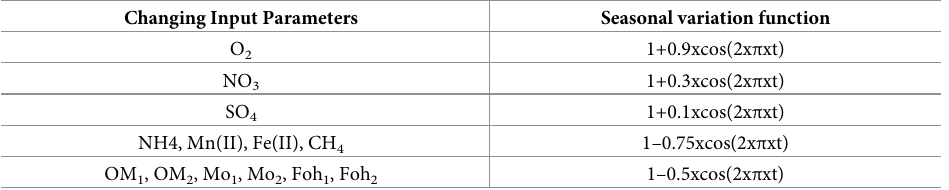
Table 2. Seasonal variations in boundary concentration for a list of modeled species calculated by various cosines functions. For the seasonal model, the boundary conditions from in Table 1 were multiplied with the seasonal func- tions given here. t is the time in